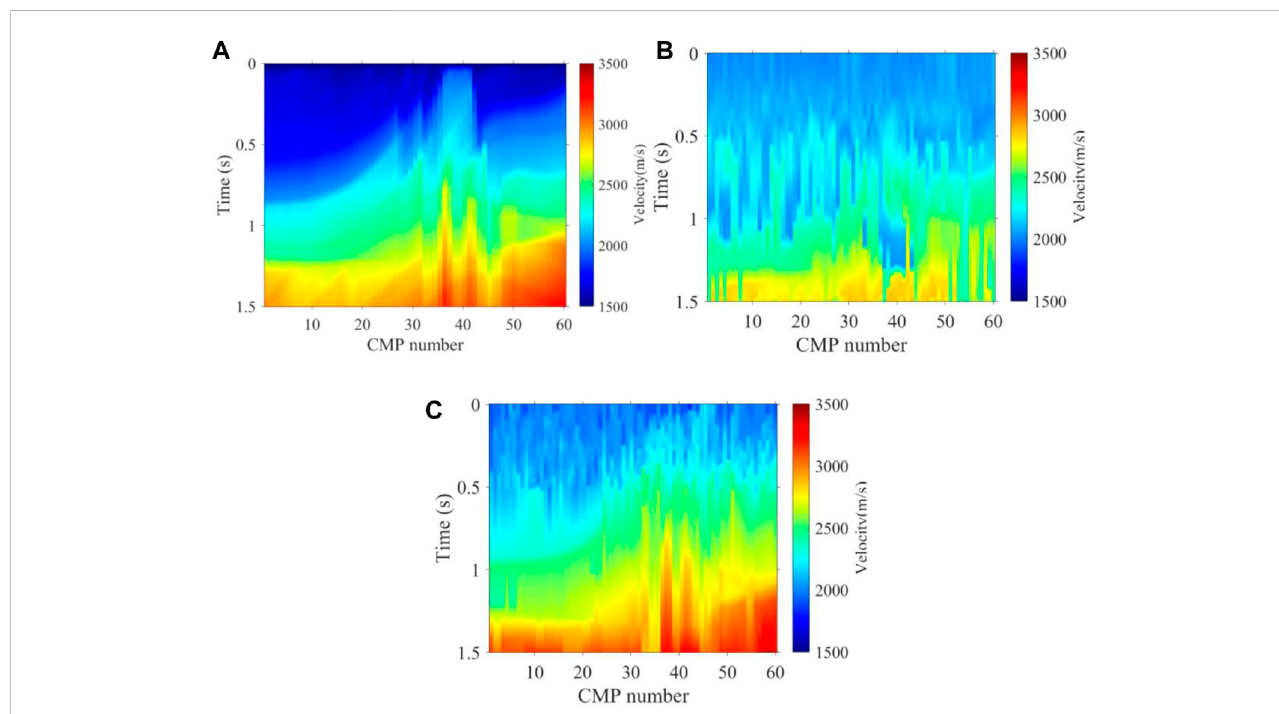
FIGURE 10 Stackingvelocity fi eldofsyntheticdatawithrandomnoiseandstrongenergyregularnoise. (A) Truevelocity, (B) K-meansintelligentpickingvelocity,and (C) intelligent picking velocity by the method proposed.